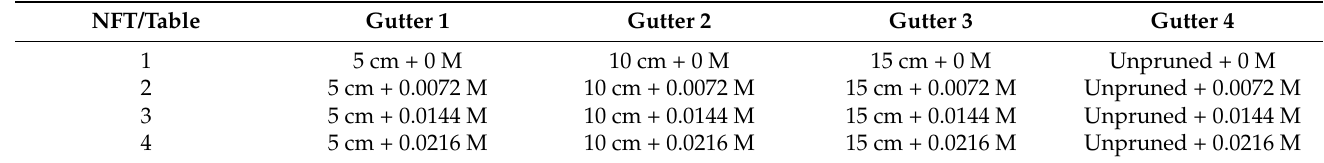
Figure 2. The experimental layout showing replicates ( n = 10) in the Nutrient Filter Technique hydroponic system (Picture: B. Bulawa). Table 6. Arrangement of each gutter on four NFT systems with different pruning levels (cm) and potassium sulphate (mL)